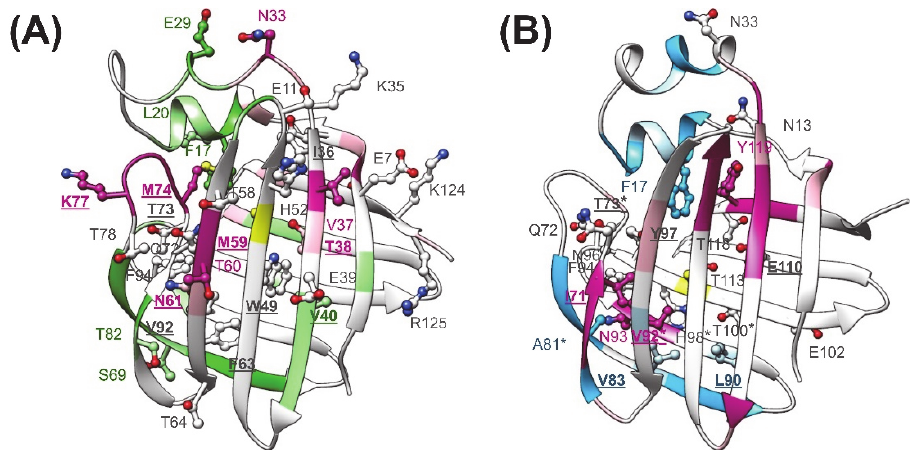
Figure 12. Structural and dynamic perturbations as a result of the mutation in the apo form of ( A ) Q51A and ( B ) Q99A are mapped onto the ribbon diagram of the corresponding MD-derived structure. Residues with increased flexibility on the ps-ns time scale in comparison to wild-type are shown in magenta for both mutants. Residues with decreased ps-ns flexibility are depicted in green (Q51A) or cyan (Q99A). Residues exhibiting above average chemical shift change as a result of the mutation are depicted in a ball-and-stick representation. Position of the mutations is indicated in yellow. Residues involved in H-bond interactions or in hydrophobic interactions with the bound bile salts in the holo form are underlined and shown in bold. Residues in Q99A human I-BABP with altered (>25%) chemical shift difference between the ground and the sparsely populated higher energy state inferred from the CPMG measurements are marked with an